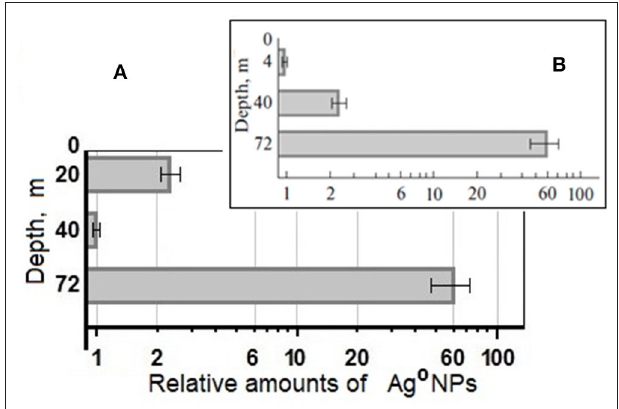
FIGURE 5 | Relative number of Ag ◦ NPs, formed at + 5 ◦ C in water samples of the Lake Untersee from different depths, normalized to the amount of biogenic nanoparticles in the sample from the depth 40m (A) , (B) relative number of Ag ◦ NPs, formed in the same water samples at + 24 ◦ C ( Skladnev et al., 2017a).